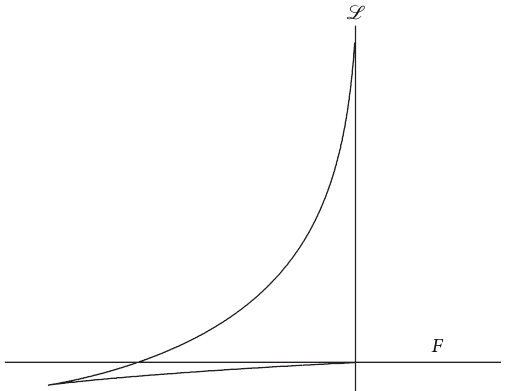
Figure 1: Typical behavior of a Lagrangian. Cusp corresponds to 𝐹 󸀠 = 0